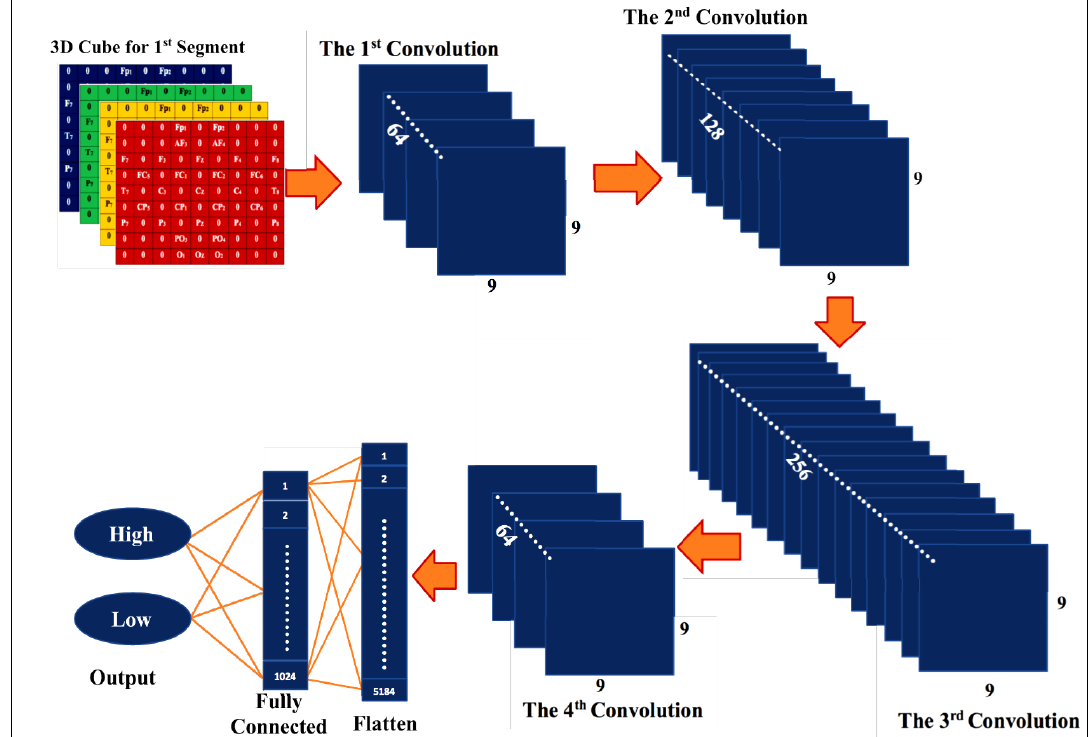
Figure 7. The classification process using CNN method for first 3D Cube